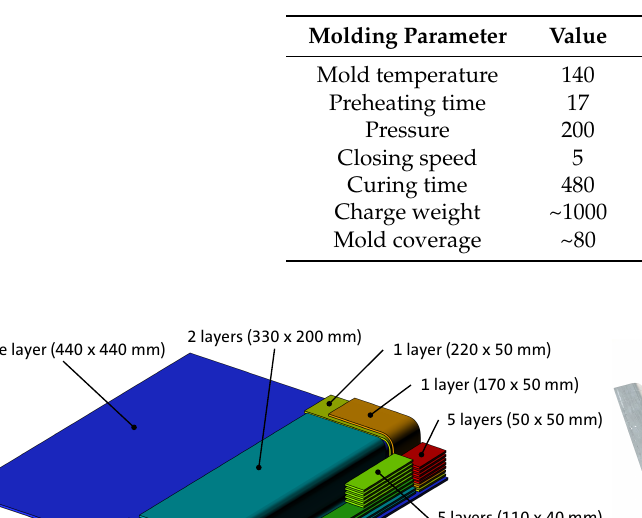
Figure 4. ( a ) CAD images of the upper and lower mold half of a research tool with a ribbed hat profile tool insert designed for compression molding of carbon fiber sheet molding compounds (CF-SMCs); ( b ) CAD geometry of the ribbed hat profile part with varying rib heights and thicknesses. Table 2. Compression molding processing conditions.